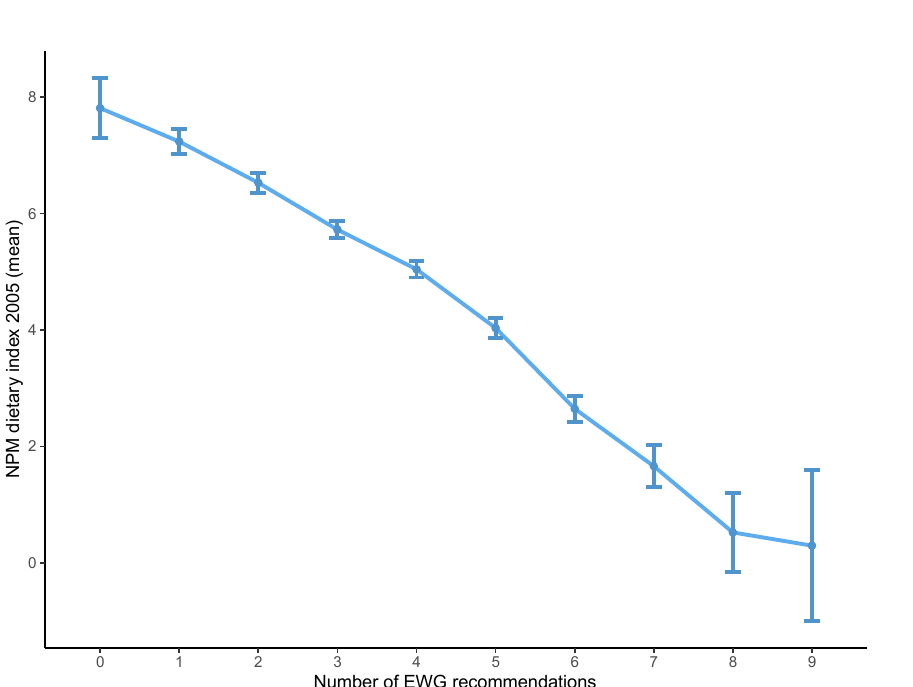
Figure 1. Mean NPM dietary index 2005 according to the number of recommendations underpinning the EWG achieved by individuals. The NPM dietary index was calculated as the weighted average of NPM for all foods included in each individual’s diet. The EWG score was calculated as the total number of recommendations underpinning the EWG that were met by each individual’s diet. The mean of the NPM dietary index was plotted for all individuals achieving each level of the EWG score (0 to 9), with 95% confidence intervals. EWG, Eatwell Guide; NPM, nutrient profiling model.